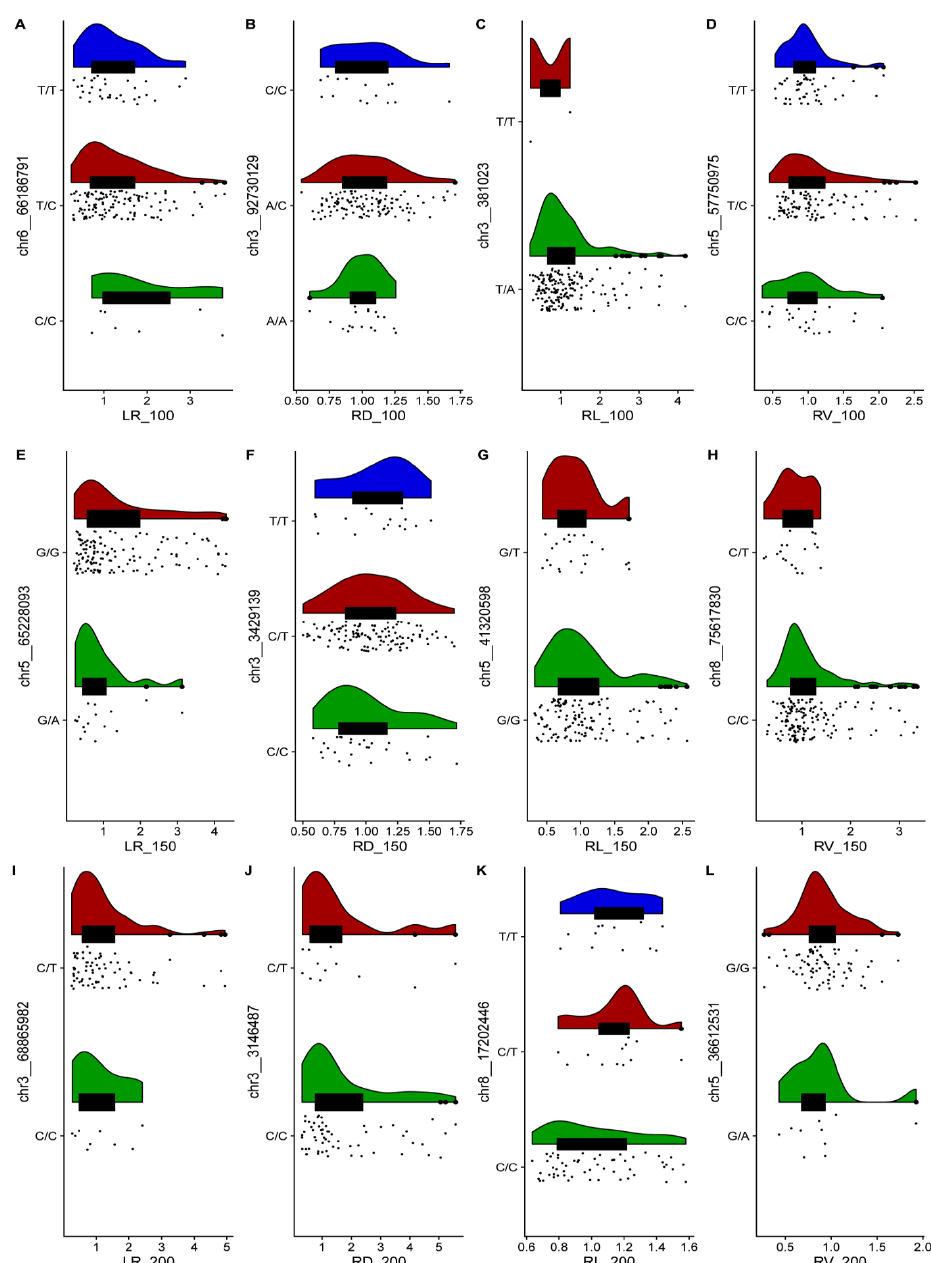
Figure 3. Raincloud plots of the highest distribution of the salt stress of plants with relevant SNP genotypes. The top plots represent the kernel density estimation, the middle plots represent box diagrams, and the bottom plots represent dithering scatter diagrams. Different colors represent different genotypes. ( A – D ) represents the genotype of Chr6__66186791, Chr3__92730129, Chr6__381023 and Chr6__57750975 at 100mM salt concentrations. ( E – H ) represents the genotype of chr5__65228093, Chr3__3429139, chr5__41320598 and chr8__75617830 at 150mM salt concentrations. ( I – L ) represents the genotype of chr3__68865982, chr3__3146487, chr8__17202446 and chr5__36612531 at 200mM salt